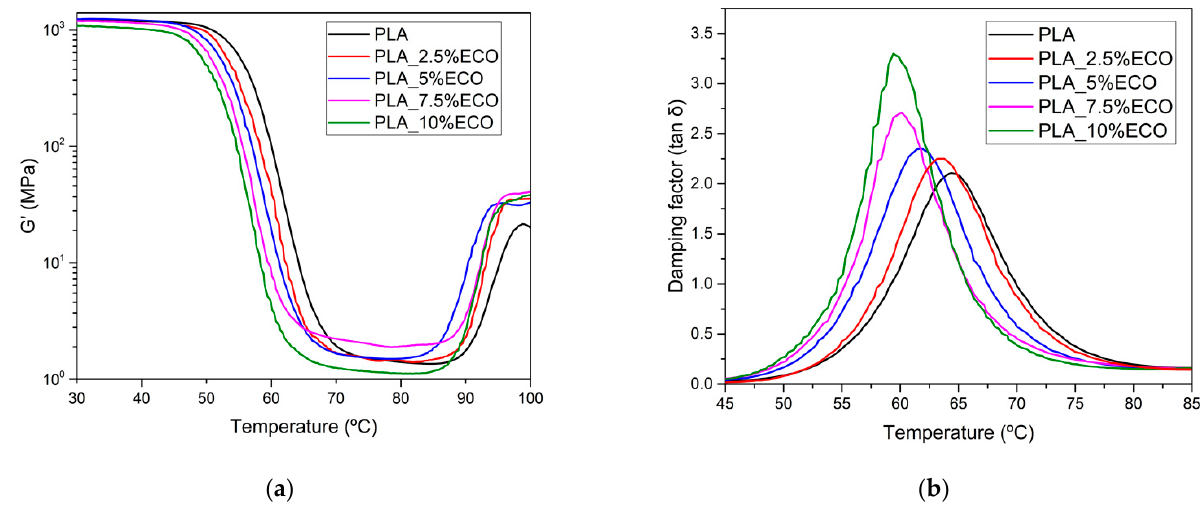
Figure 6. Plot evolution of dynamic mechanical thermal analysis (DMTA) of PLA with different ECO contents: ( a ) storage modulus (G’); ( b ) damping factor (tan δ ).